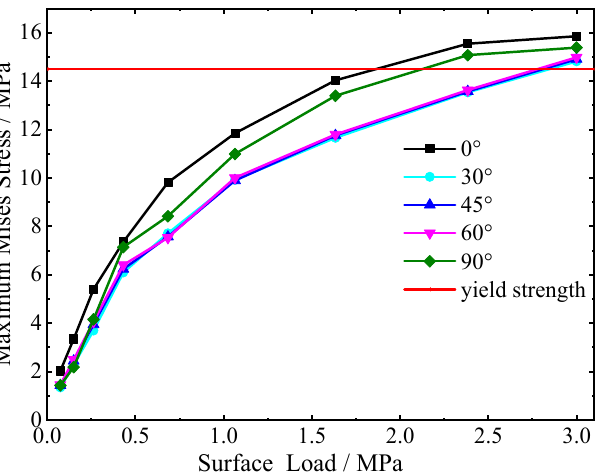
Figure 15. Maximum Mises stress in HDPE pipeline with various defect depths.